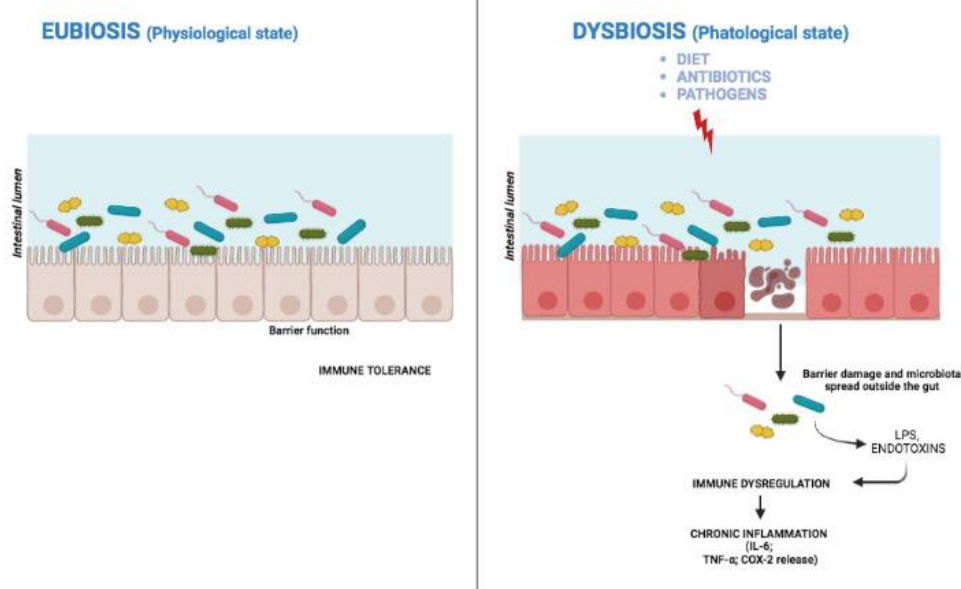
Figure 2. In eubiosis, the immune system tolerates the microbiota. Factors such as diet, antibiotics and microbial infections may cause a condition of dysbiosis that leads to diseases. and microbial infections may cause a condition of dysbiosis that leads to